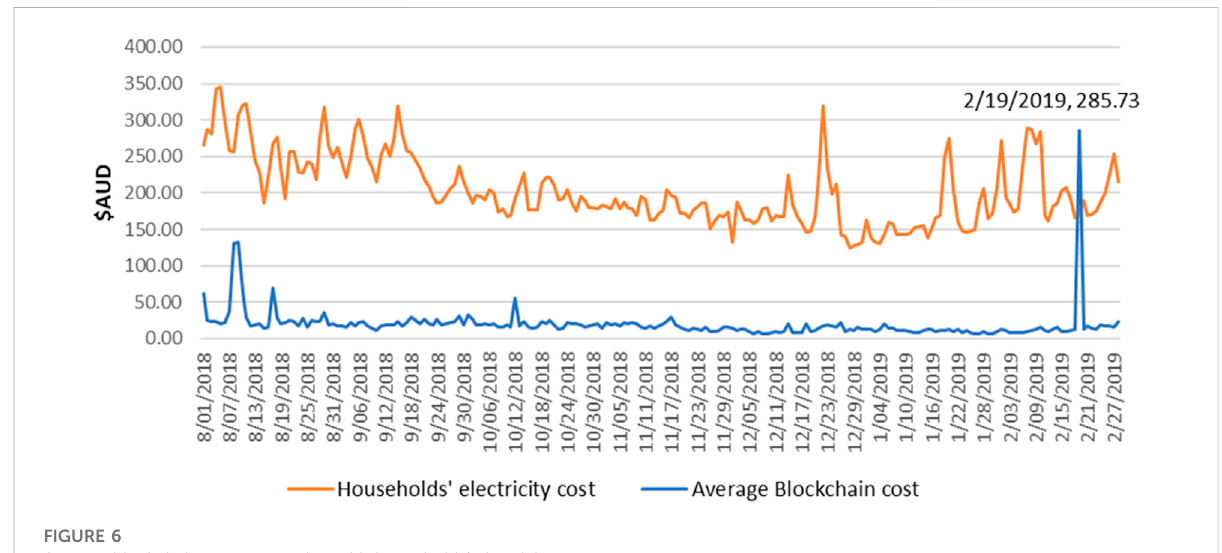
FIGURE 6 Average blockchain cost comparing with households ’ electricity